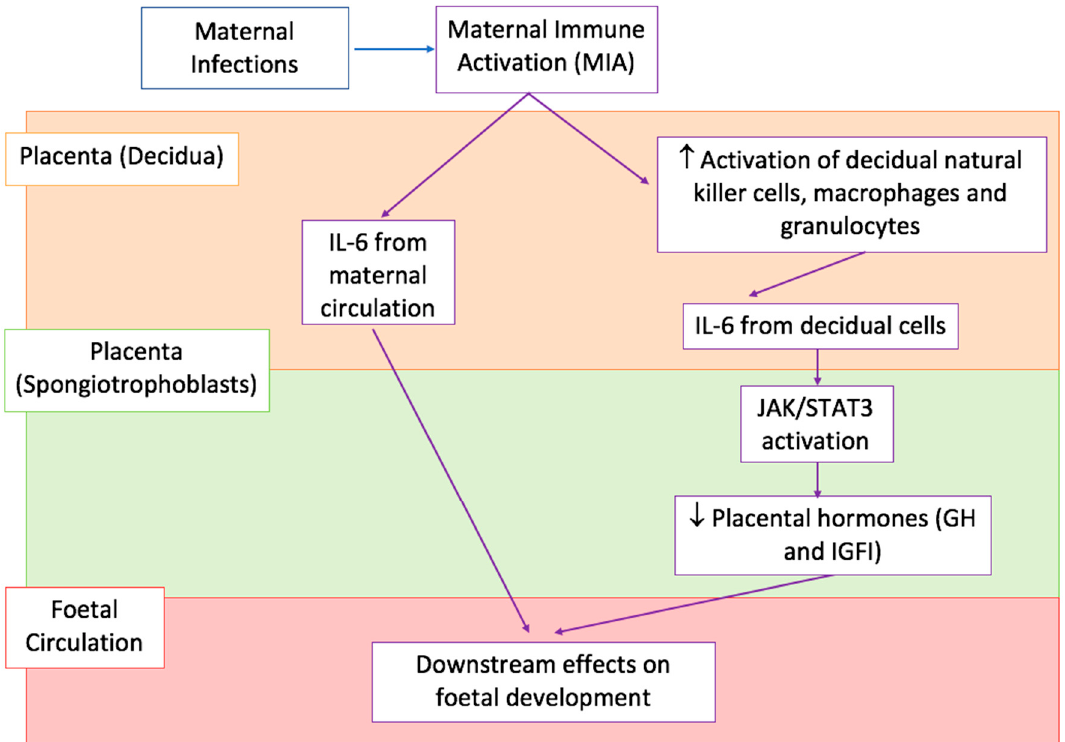
Figure 3. Proposed e ff ects of IL-6 on the prenatal environment. A simplified graphical representation of the downstream e ff ects of IL-6 production as a consequence of MIA by maternal infections, with arrows indicating the sequence of events in various body compartments, placenta decidua shown in light orange at the top, placenta spongiotrophoblasts shown in light green in the middle, and foetal circulation shown in pink at the bottom. MIA causes an increase in IL-6 in the peripheral maternal circulation and placenta decidua. It can either directly cross the placenta and enter the foetal circulation (arrows in the left) or cause the increased activation of decidual immune cells (arrows in the right) which consequently produce IL-6 in the maternal compartment of the placenta. IL-6 produced from decidual cells acts on IL-6 receptors (IL-6R α ) in the spongiotrophoblast layer and causes downstream activation of JAK / STAT3 signalling. This down-regulates placental GH and IGFI production. JAK / STAT3 stands for Janus tyrosine kinase / signalling transducer and activation of transcription, GH is Growth Hormone, and IGFI is Insulin-like growth factor 1 [113,116].